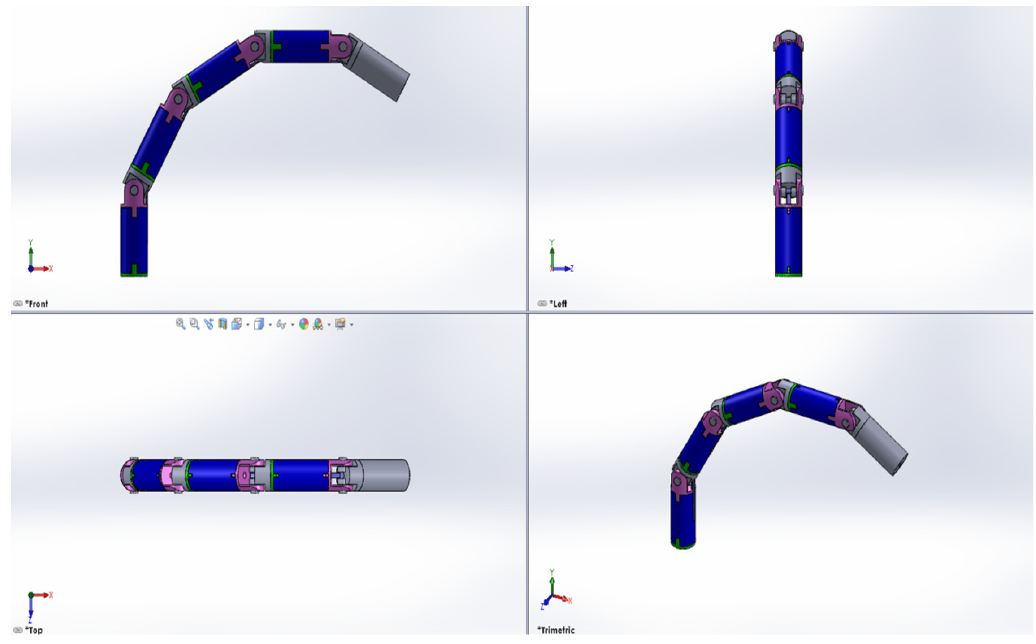
Figure 15. Computer generated images showing multi-degrees-of-freedom actuations achieved with a stack of four latching-type electromagnetic actuators. Table 4. Detailed parameters of the optimised actuator.